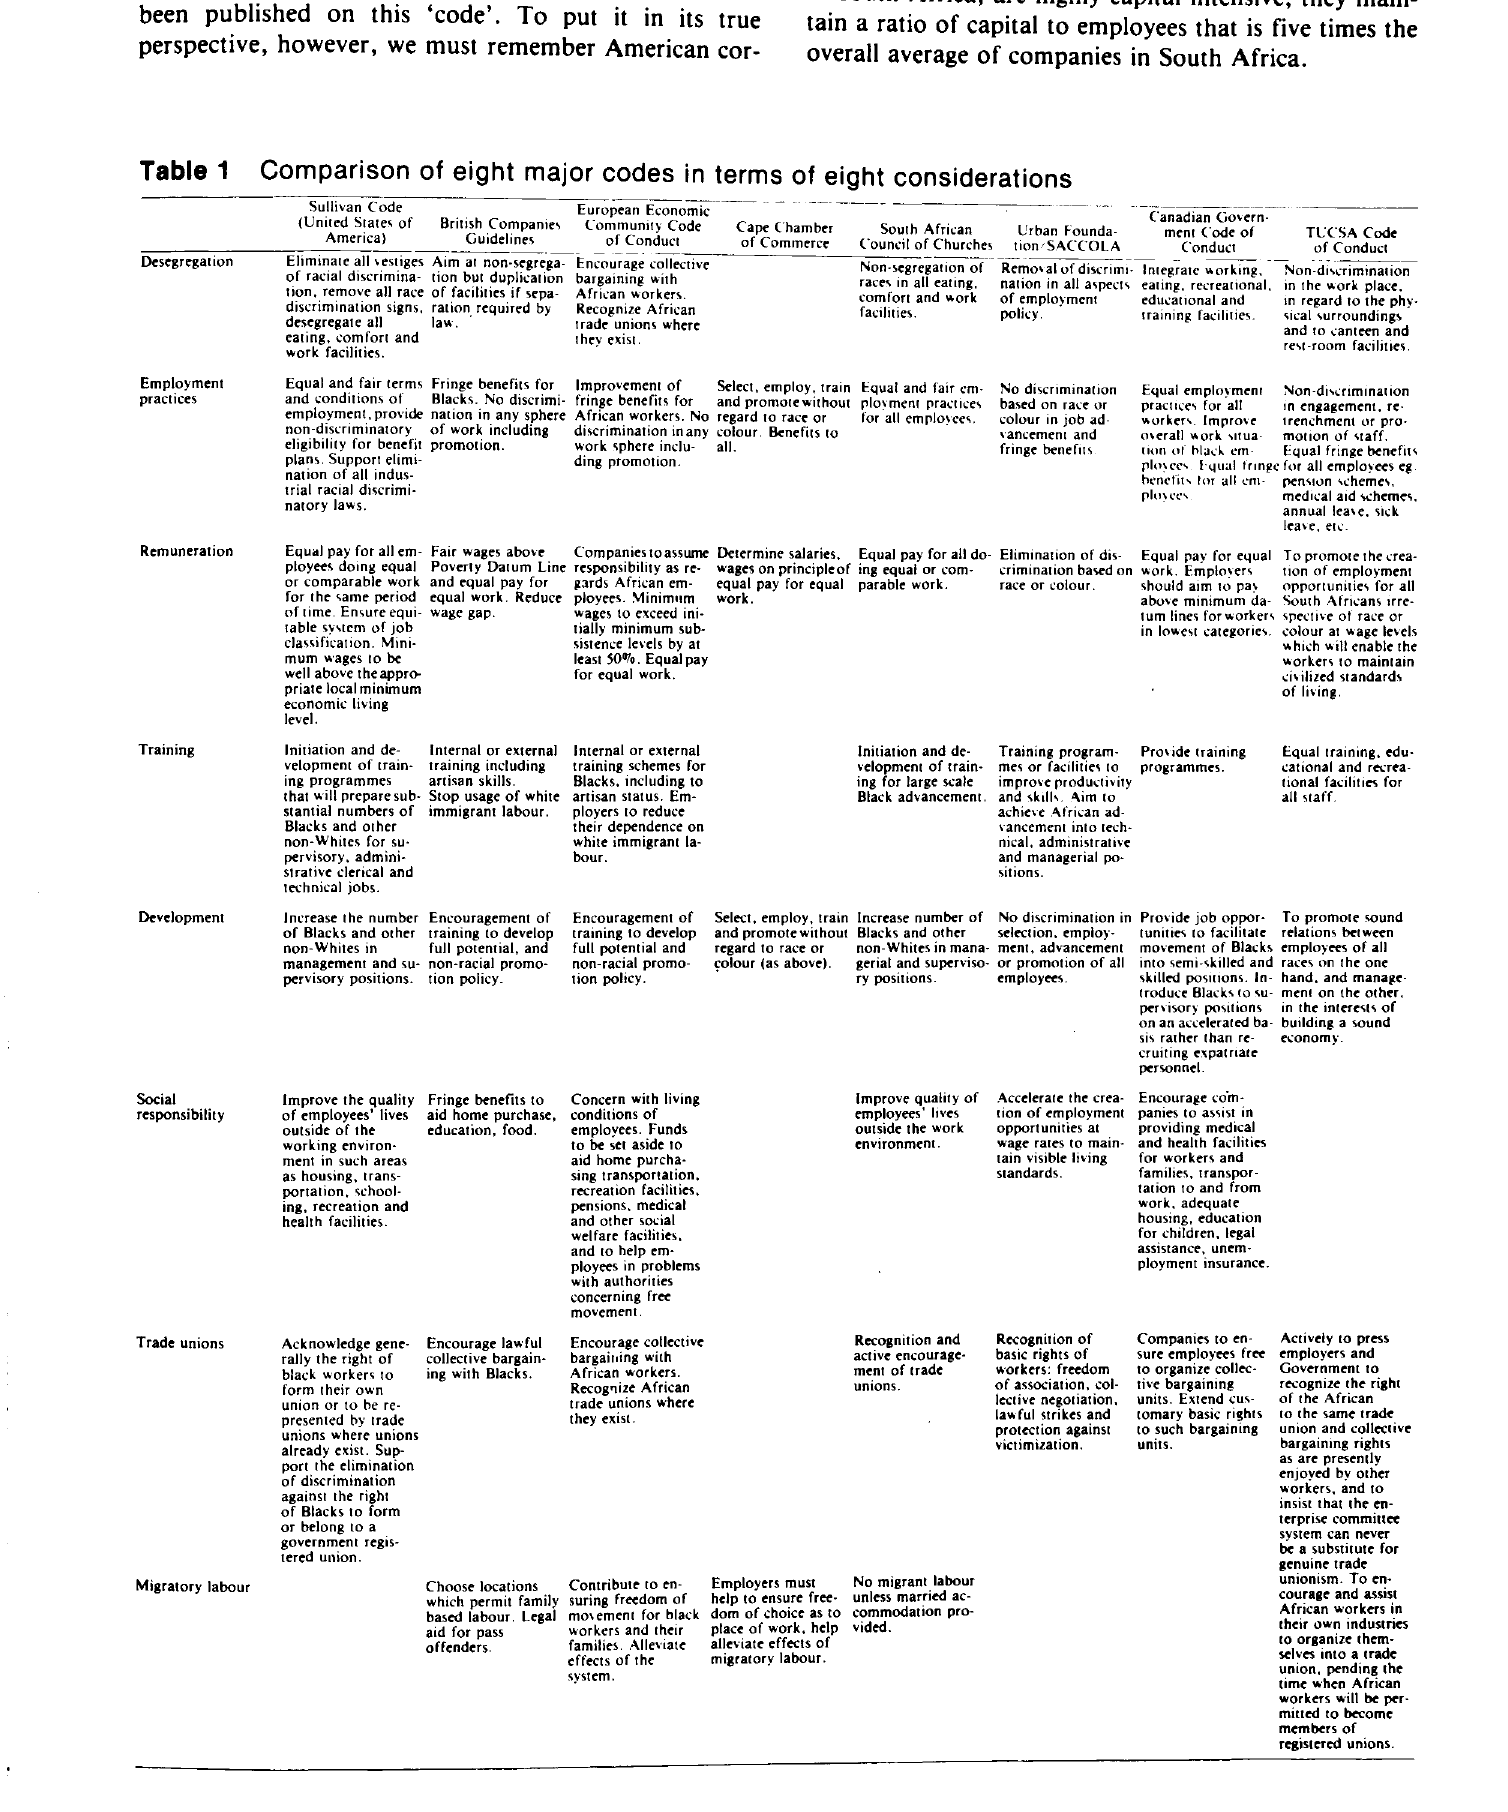
Employment practices